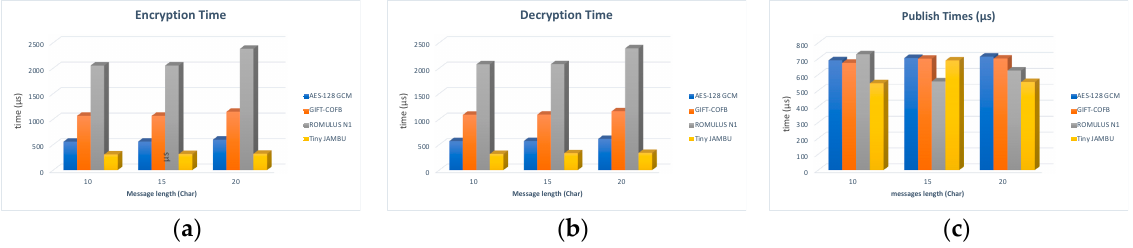
Figure 6. Lightweight Cryptographic Performance on NodeMCU on WiFi Network Used Anonymous Account. ( a ) Encryption Time; ( b ) Decryption Time; ( c ) Message Publication Time to MQTT Server. Table 3. Lightweight Cryptographic Encryption and Decryption Performance on NodeMCU with 10 Characters Messages used Anonymous Account.